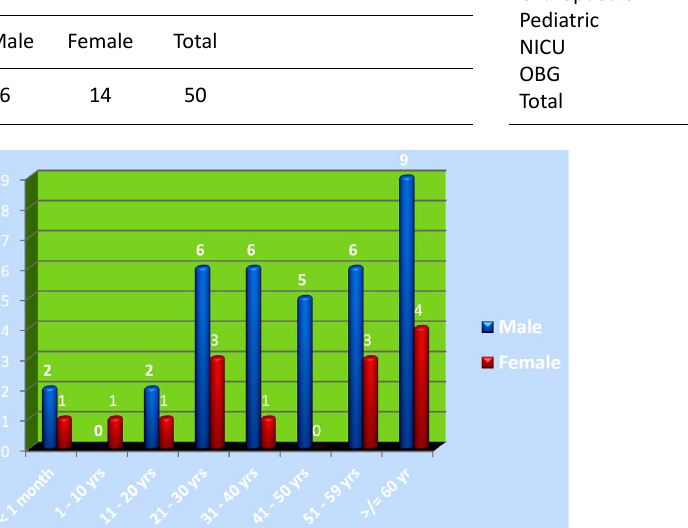
Table 2. MDR Acinetobacter isolates in relation to